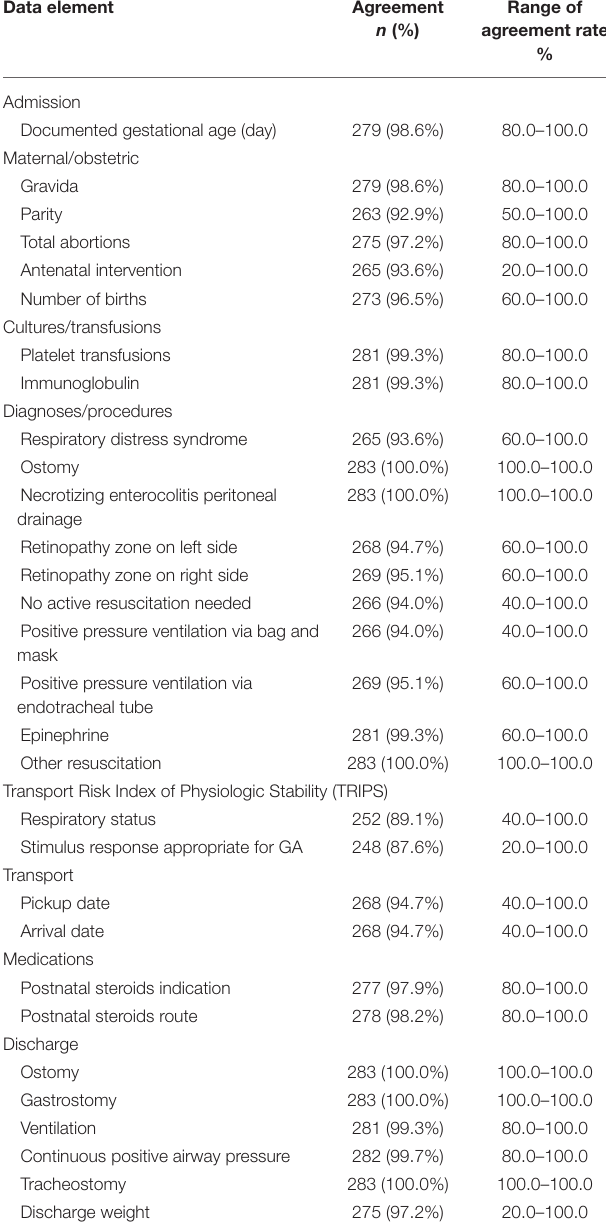
TABLE 4 | Agreement number and percentage for less-important